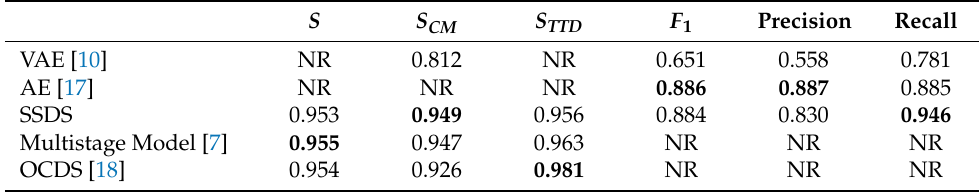
Table 3. C-Town; performance comparison from the Test 2